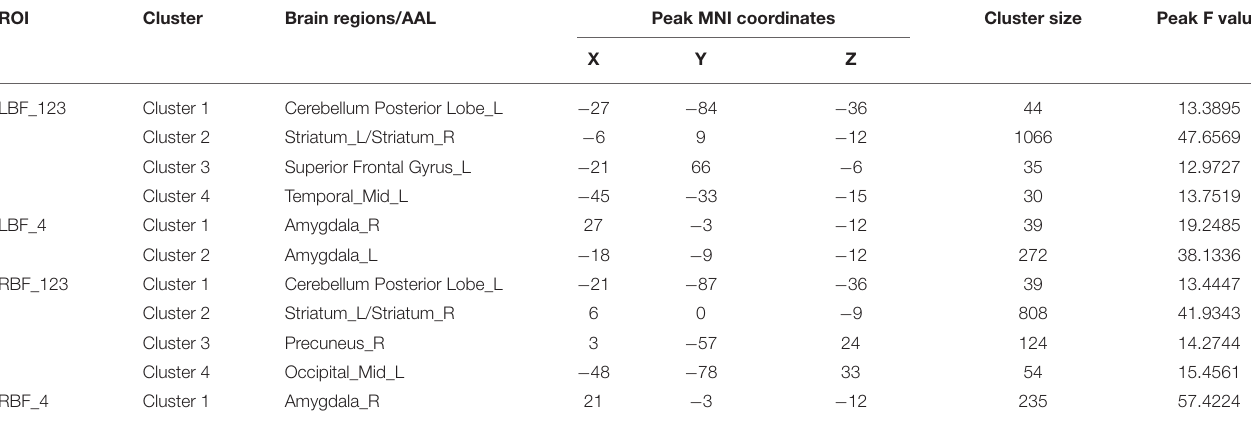
TABLE 2 | Group differences in